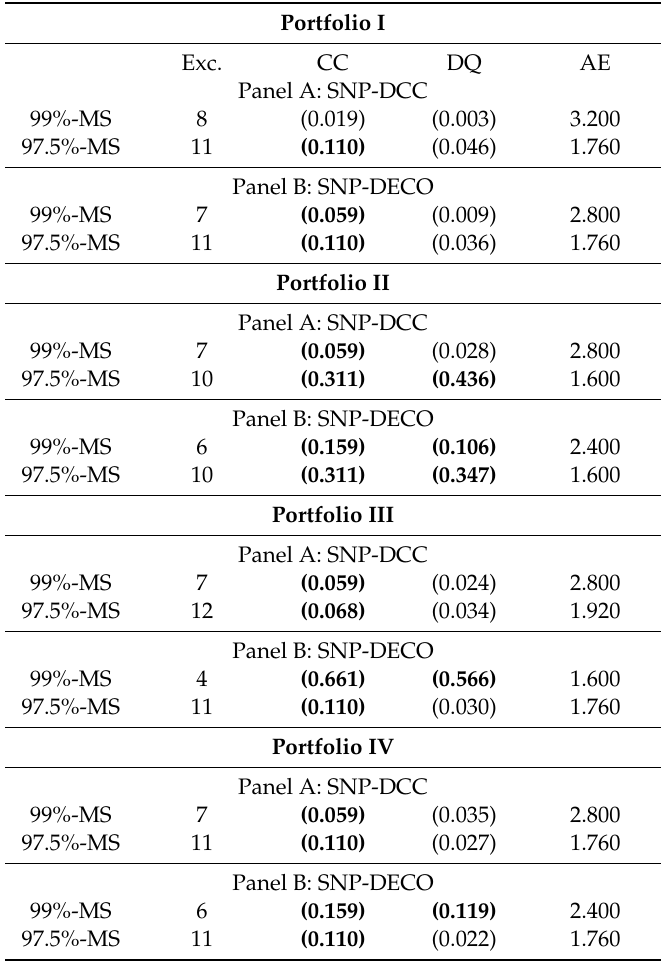
Table 4. Median shortfall Backtesting for semi-nonparametric (SNP) DCC and DECO